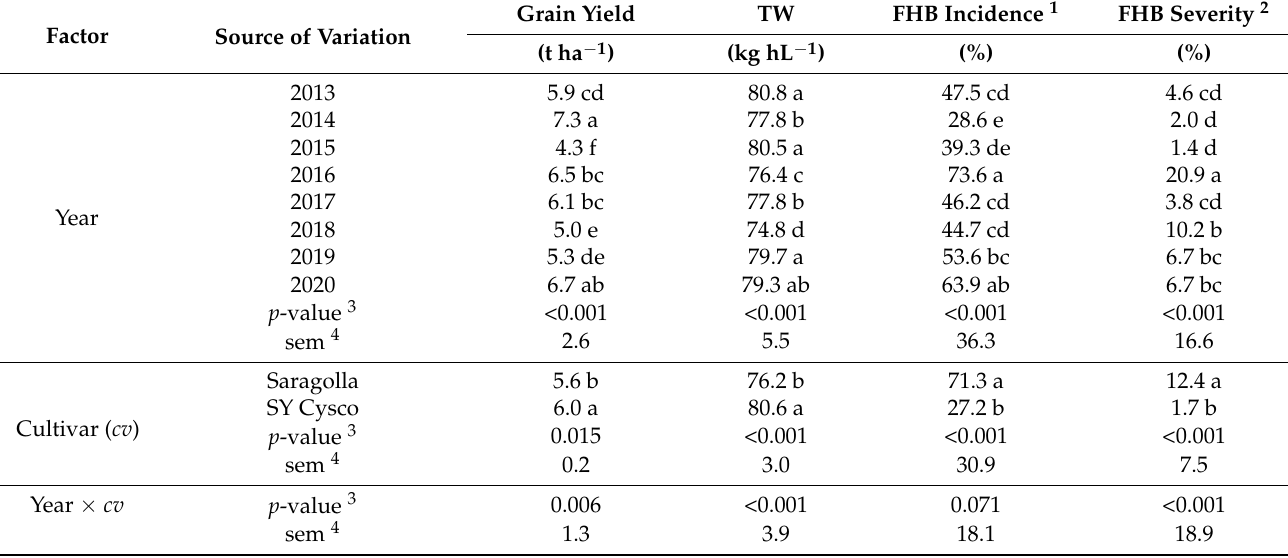
Table 3. Effects of the growing season and durum wheat cultivar with different degrees of Fusarium head blight (FHB) susceptibility on the grain yield (Yield), test weight (TW), FHB incidence (FHB Inc) and severity (FHB Sev) in NW Italy during the 2012—2020